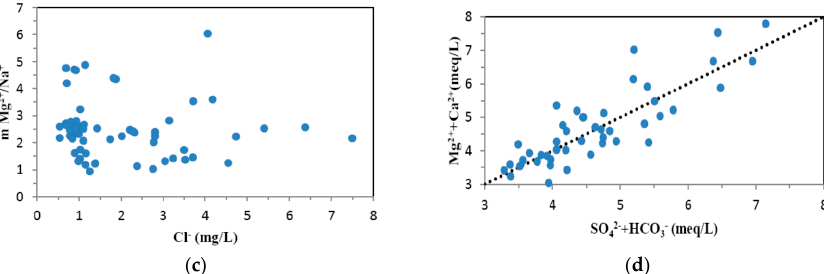
Figure 8. Relationships between various ions in groundwater of the study area, ( a ) Cl − and TDS; ( b ) Cl − and Na + ; ( c ) Cl − and mMg 2+ /Na + ; and ( d ) Ca 2+ + Mg 2+ and SO 42 − + HCO 3 − .